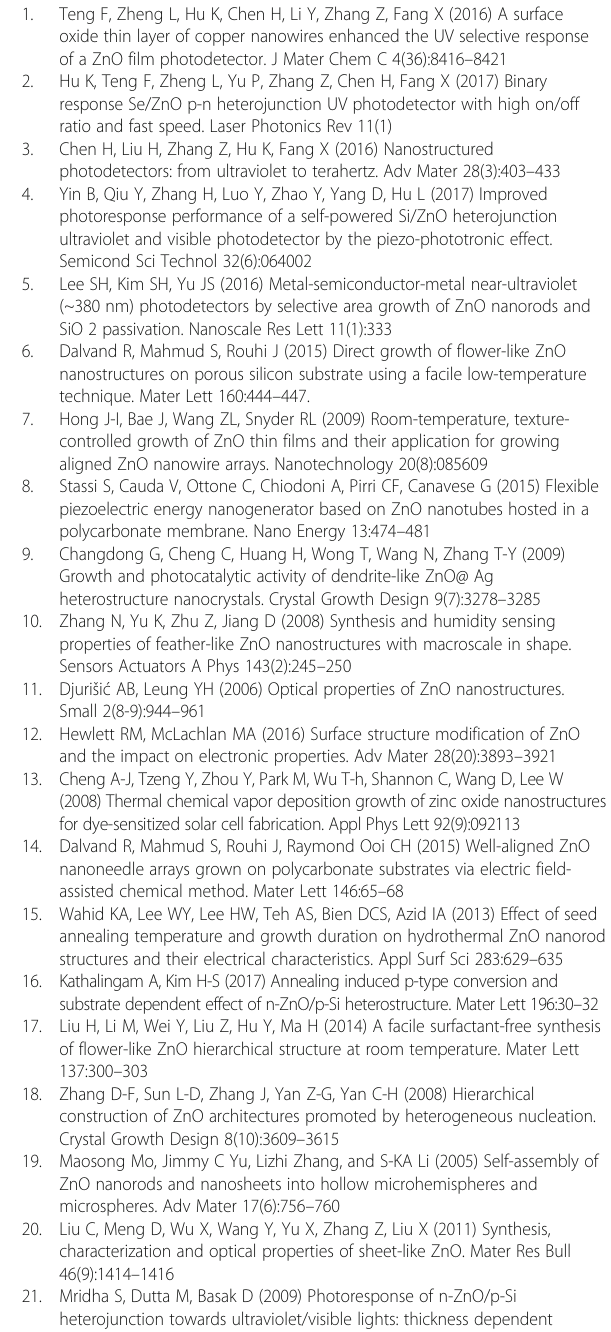
Table 1 The photo-response parameters of the feather-like ZnO/p-Si and p-Si planar structures